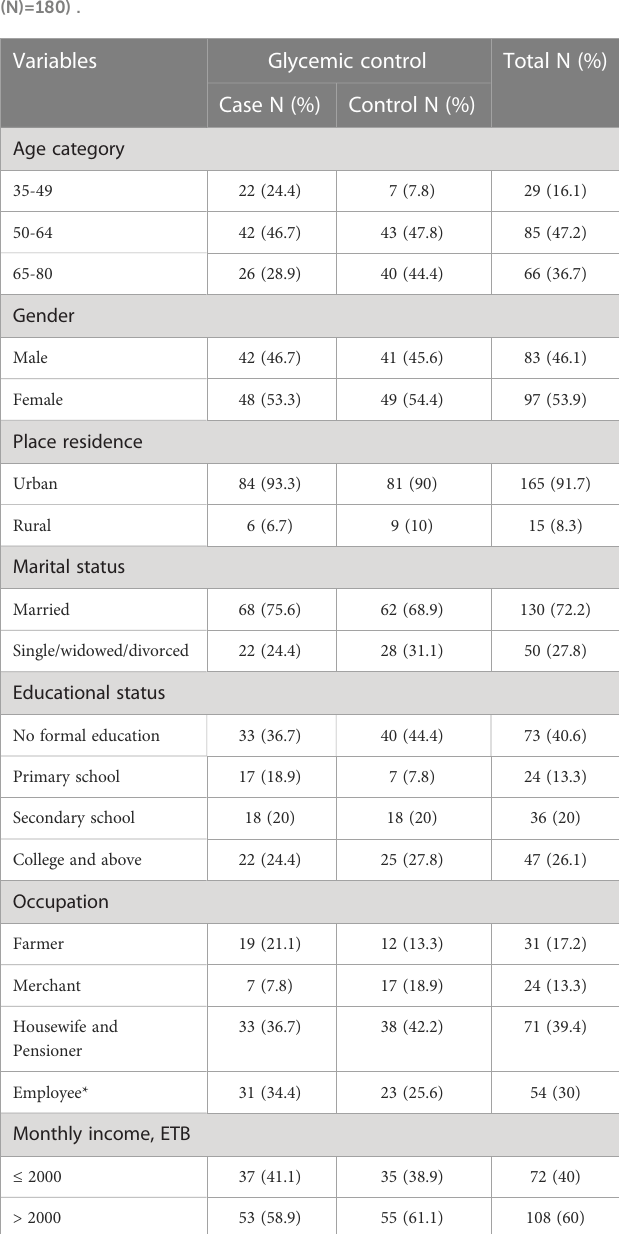
TABLE 1 Socio-demographic characteristics of type 2 diabetes mellitus patients at DM clinic of UoGCSH, Northwest Ethiopia, 2020 (Total number (N)=180) .